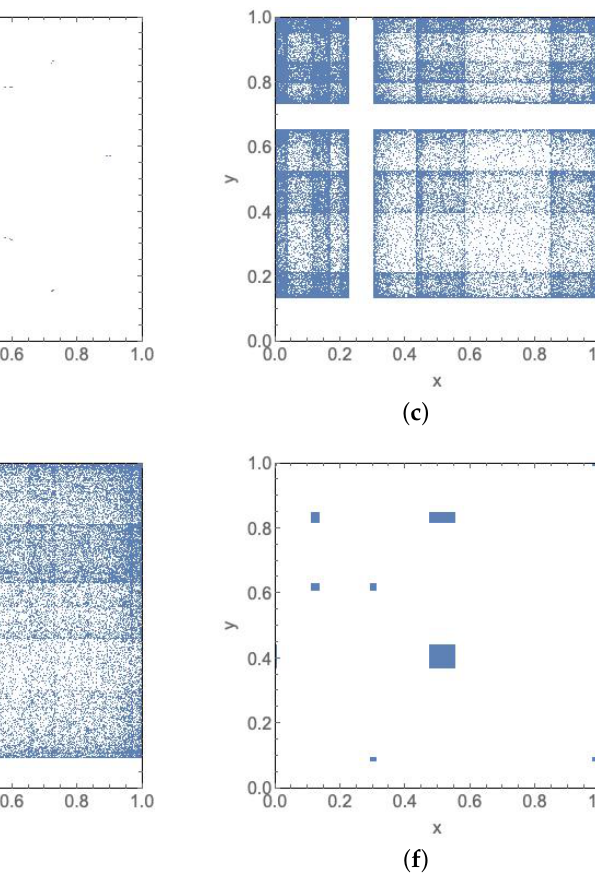
Figure 20. ω -limit sets for Matsumoto-Nonaka’s model. The value of the parameter α is α = 1.7. ( a ) β = 0.59, x 0 = 0.4 and y 0 = 1.2; ( b ) β = 0.605, x 0 = 0.4 and y 0 = 0.1; ( c ) µ = 0.635, x 0 = 0.4 and y 0 = 0.2; ( d ) β = 0.65, x 0 = 0.4 and y 0 = 0.1; ( e ) β = 0.695, x 0 = 0.4 and y 0 = 0.2; ( f ) β = 0.71, x 0 = 0.4 and y 0 = 0.7. We have computed orbits of length 200,000 and we have drawn the last 100,000 points.